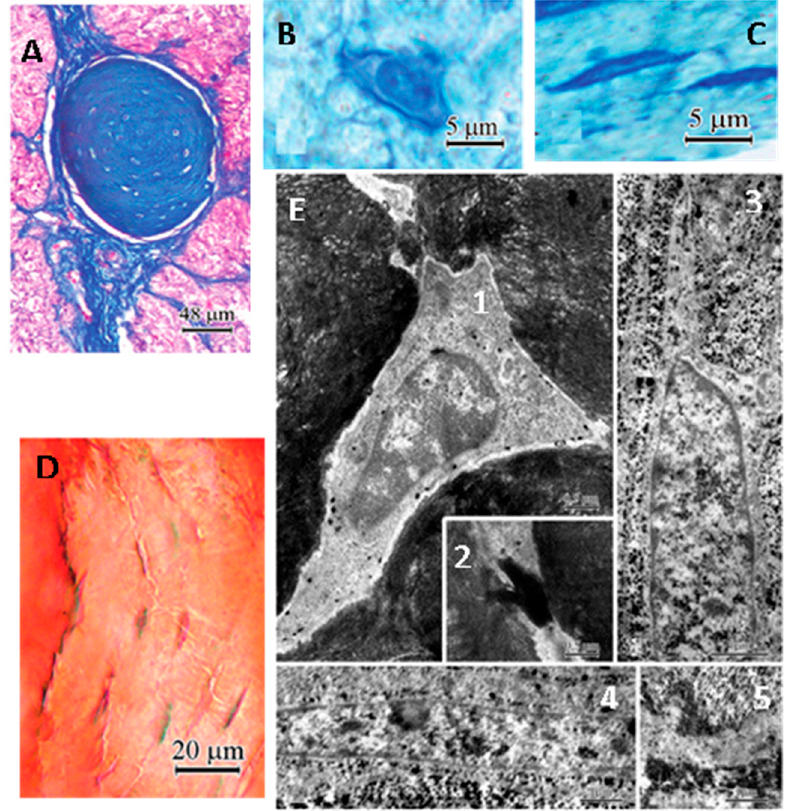
Figure 5. Histology and ultrastructure of cells located in a concretion of the turkey pineal gland. ( A ) mature concretions identified with Mallory’s stain. Two types of cells are present in the concretion (semi-thin section stained with toluidine blue); ( B ) polygonal cells; ( C ) elongated cells; ( D ) The presence of calcium in the concretions was demonstrated with Alizarin red S; note the characteristic appearance of cells located in the concretion; ( E ) ultrastructure of cells located in the calcified area (fixation with the PPA method). 1: the osteocyte-like cell surrounded by mineralized collagen fibrils in the central part of the calcification area. Note the “halo” around the cell and large pyroantimonate precipitate located mainly outside the cell membrane, 2: the junction of processes of osteocyte-like cells, 3: a cell showing a fibrocyte-like appearance in the peripheral part of the calcification area. Note the extra-cellular matrix containing collagen and calcium deposits, 4: numerous calcium precipitates in the intercellular spaces in the peripheral part of the calcification area, 5: The cell process with scattered deposits in the middle part of the concretion. Note the adjacent extra-cellular matrix rich in collagen and pyroantimonate precipitates. Modified from Przybylska-Gornowicz et al. [159].